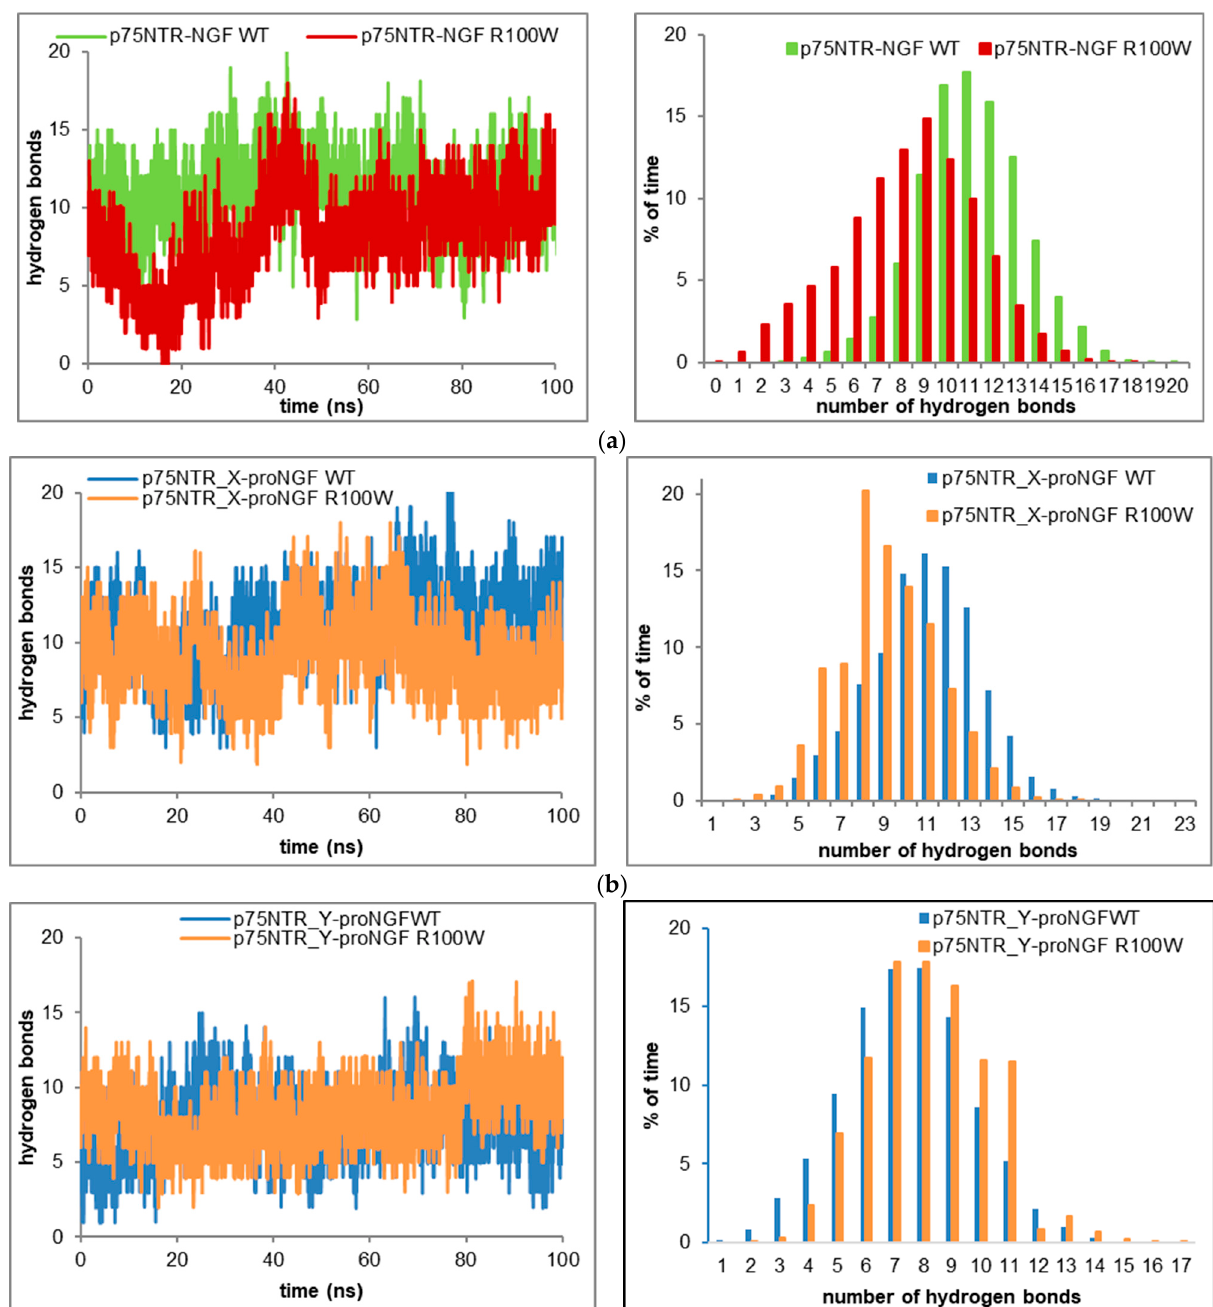
Figure 9. Plots of the number ( left panel) and percentage of time persistence ( right panel) of the intermolecular hydrogen bonds in the complexes: ( a ) p75NTR/NGF, ( b ) p75NTR_X/proNGF, and ( c ) p75NTR_Y/proNGF.